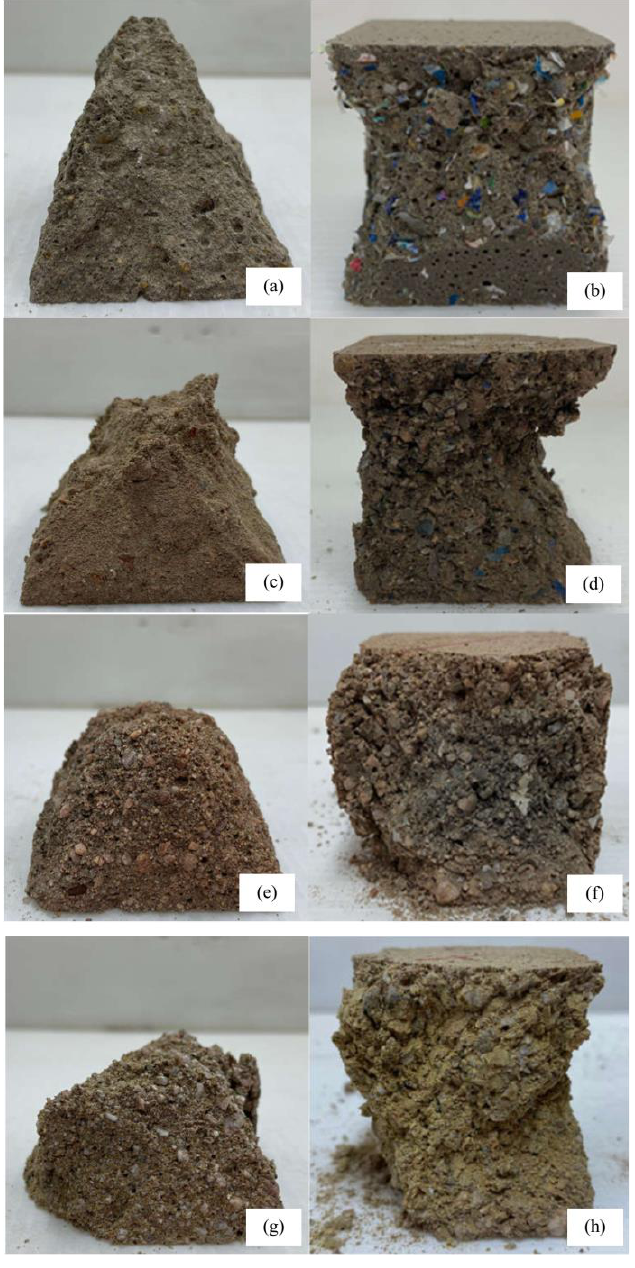
Figure 16. Specimens after exposure to elevated temperatures and being tested for compressive strength: ( a ) LG00-25 °C, ( b ) LG10-25 °C, ( c ) LG00-300 °C, ( d ) LG10-300 °C, ( e ) LG00-600 °C, ( f ) strength: ( a ) LG00-25 ◦ C, ( b ) LG10-25 ◦ C, ( c ) LG00-300 ◦ C, ( d ) LG10-300 ◦ C, ( e ) LG00-600 ◦ C, ( f ) LG10- LG10-600 °C, ( g ) LG00-900 °C, and ( h ) LG10-900 °C. 600 ◦ C, ( g ) LG00-900 ◦ C, and ( h ) LG10-900 ◦